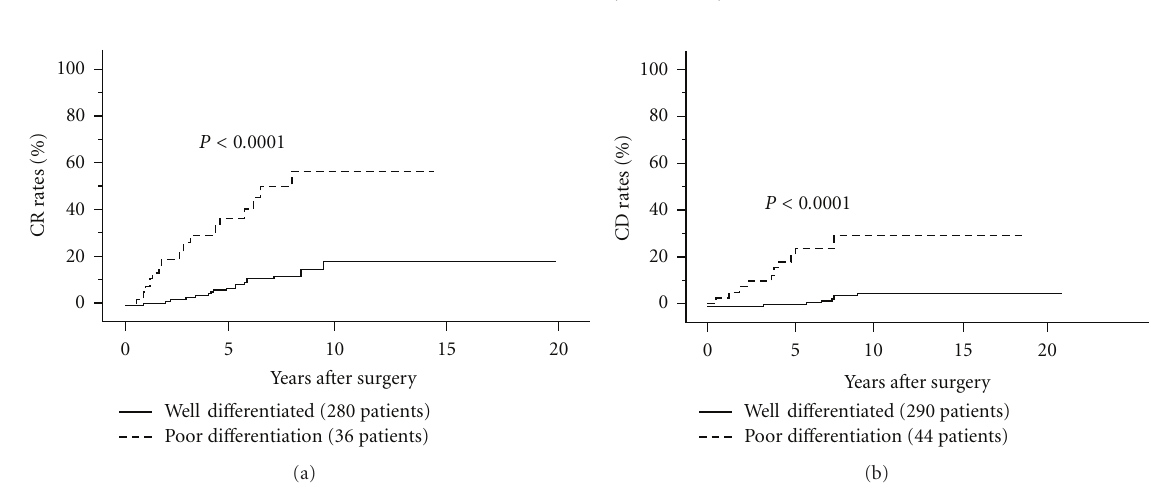
Figure 12: CR rates of FTC patients with and without PDC